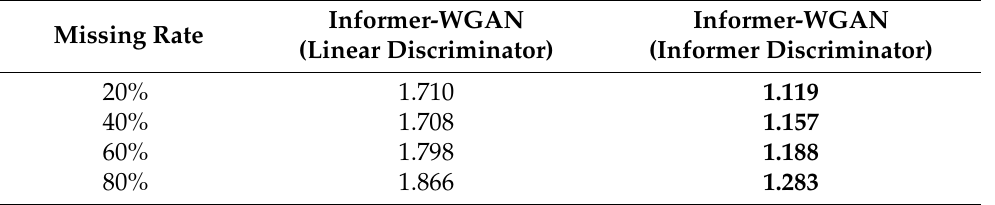
Table 10. The ablation experiment results (PRMSE) of different discriminators on electricity